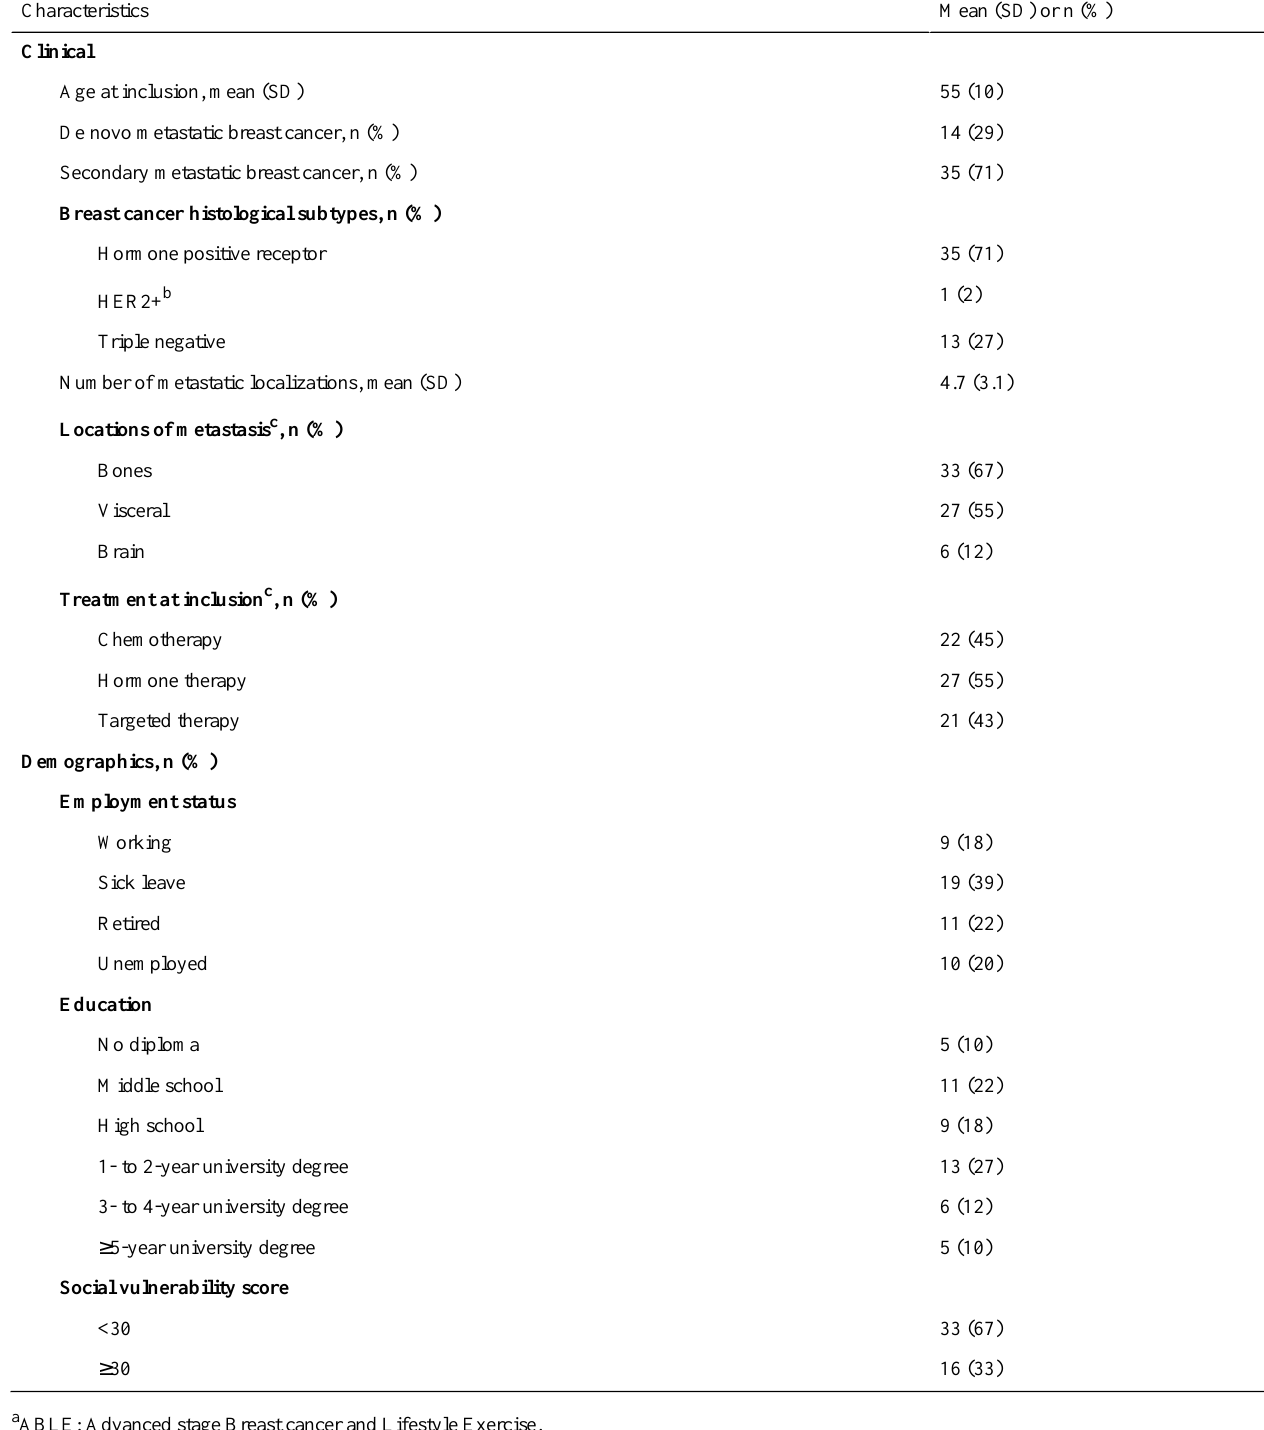
Table 1. Demographics and baseline clinical characteristics of women with metastatic breast cancer in the ABLE a Trial,